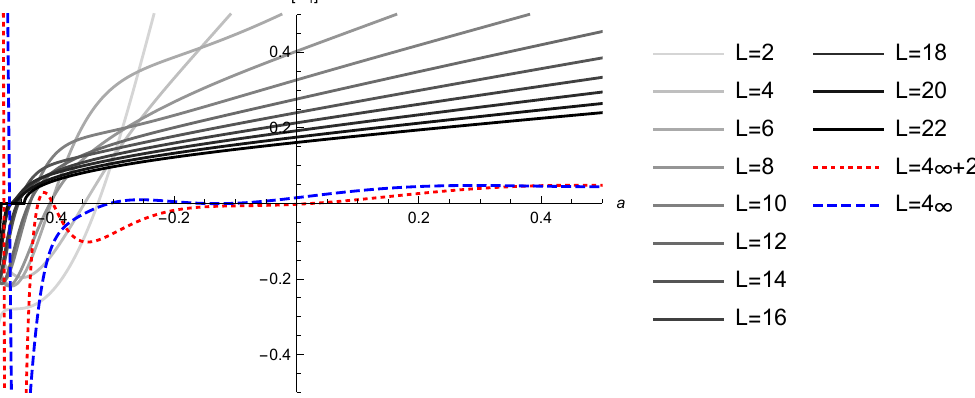
at the truncation level L . The dotted a